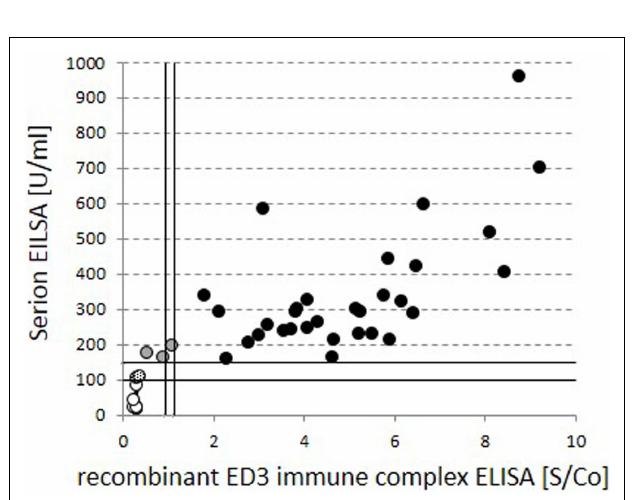
FIGURE 3 | Cases with consecutive measurements .The dot plot displays anti-TBE IgG titers from the standard ELISA for 29 separate cases with consecutive measurements. Cases with inconsistent ratings are highlighted by “#.”The variation of specific anti-TBE IgG titers was not due to variation in total IgG serum levels.